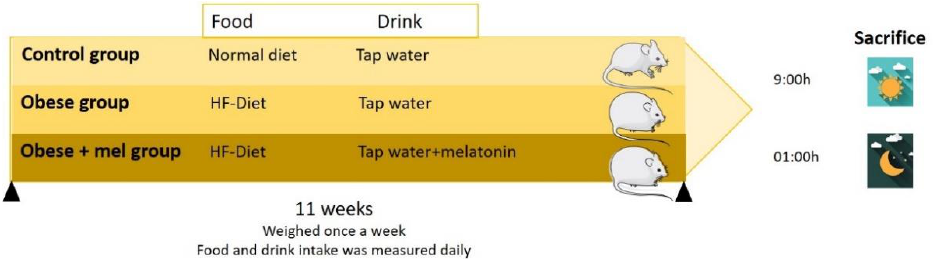
Figure 6. Study design, describing the food and drink administered to the animals resulting in the three different study groups: Control, obese and obese + melatonin group. Animals were sacrifice at two-time intervals: at light period 9:00 a.m. and at the middle of the scotophase (01:00